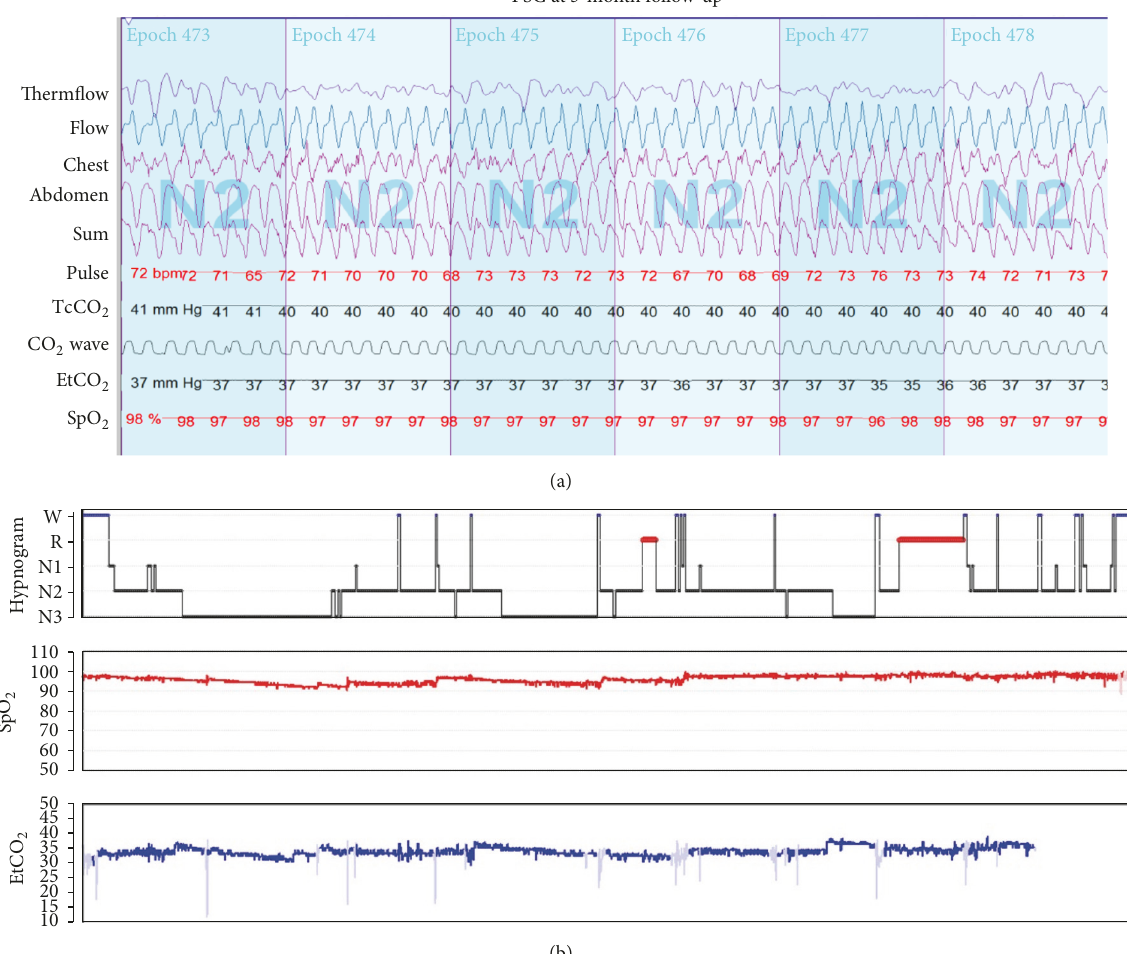
Figure 3: (a) 3-minute polysomnographical recording showing the normalization of the breathing pattern. (b) Hypnogram from the entire night illustrating the sleep stages; W: wakefulness, R: REM, N1–N3: non-REM sleep (stage 1–3), SpO 2 : oxygen saturation, and EtCO 2 : end tidal carbon